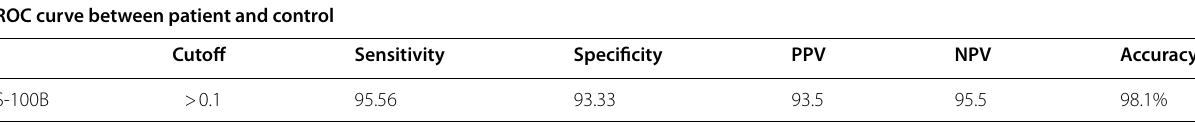
ROC curve the receiver operating curve, PPV positive predictive value, NPV negative predictive value